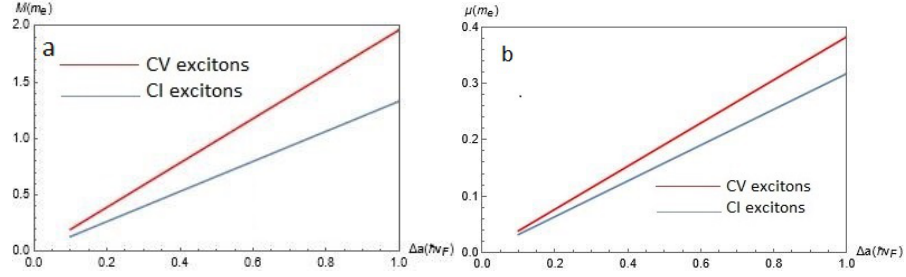
Figure 5. The effective masses of a dipolar exciton for CV and CI excitons as functions of the gap ∆ for chosen α = 0.6 for ( a ) center-of-mass exciton mass M on the left panel and ( b ) reduced exciton mass µ , on the